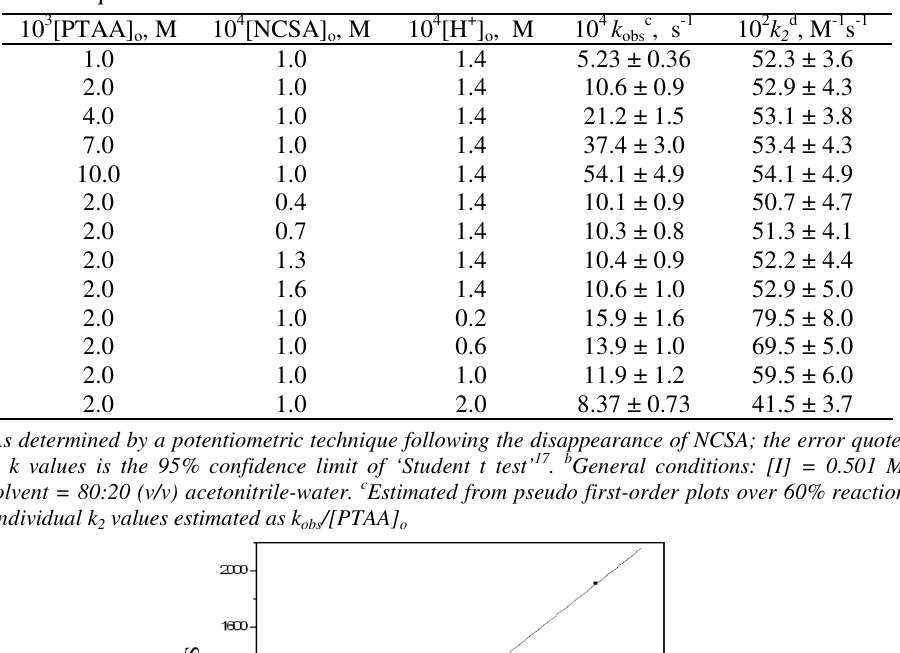
Table 1. Pseudo-first-order and second-order rate constants for the oxidation of PTAA by NCSA in aqueous acetonitrile at 298 K a,b